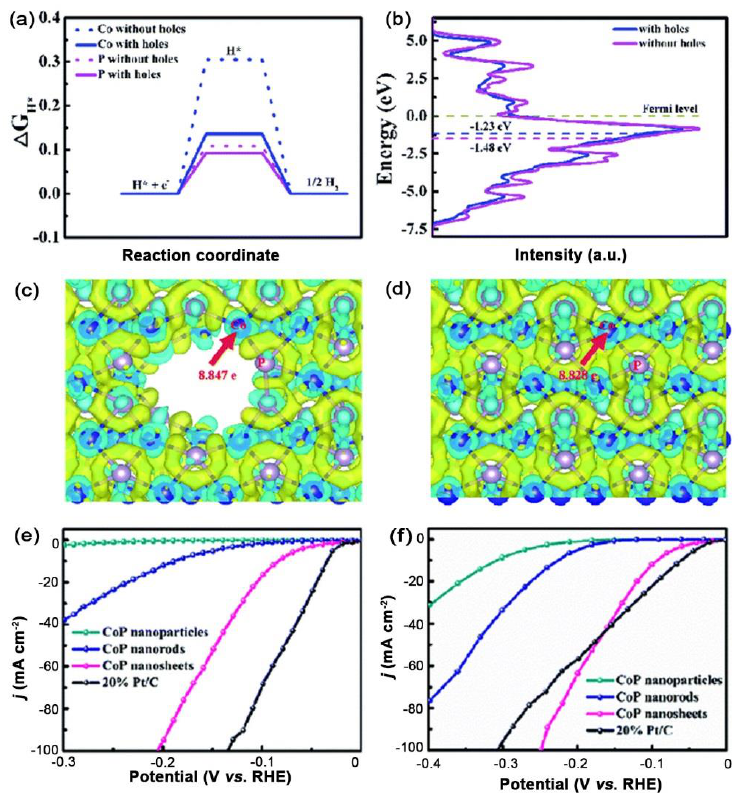
Figure 2. ( a ) The free-energy diagram of Co and P atoms at the top sites of the CoP (011) surface with and without holes, respectively. ( b ) PDOS of CoP with and without holes, respectively. The electron density difference maps of CoP ( c ) with and ( d ) without holes. Yellow and cyan represent electronic accumulation and depletion, respectively. HER polarization curves with a scan rate of 5 mV s − 1 in ( e ) 0.5 M H 2 SO 4 and ( f ) 1.0 M KOH. Reproduced with permission from ref. [93]. Copyright 2021, The Royal Society of Chemistry.